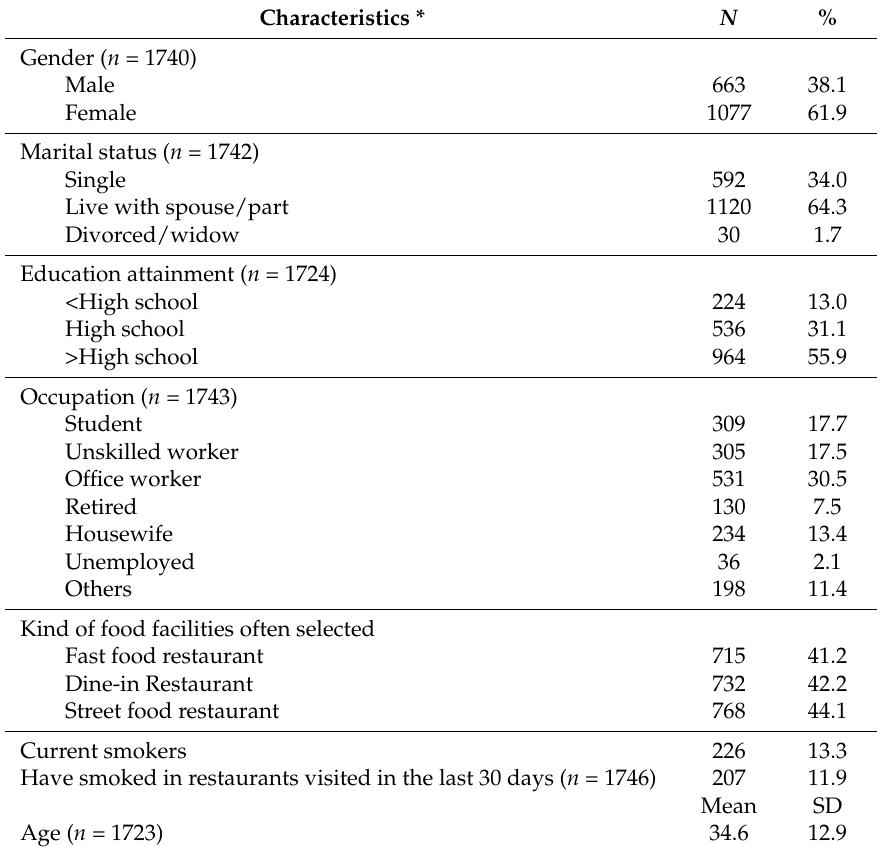
Table 1. Demographic characteristics of respondents in the restaurants used. Characteristics